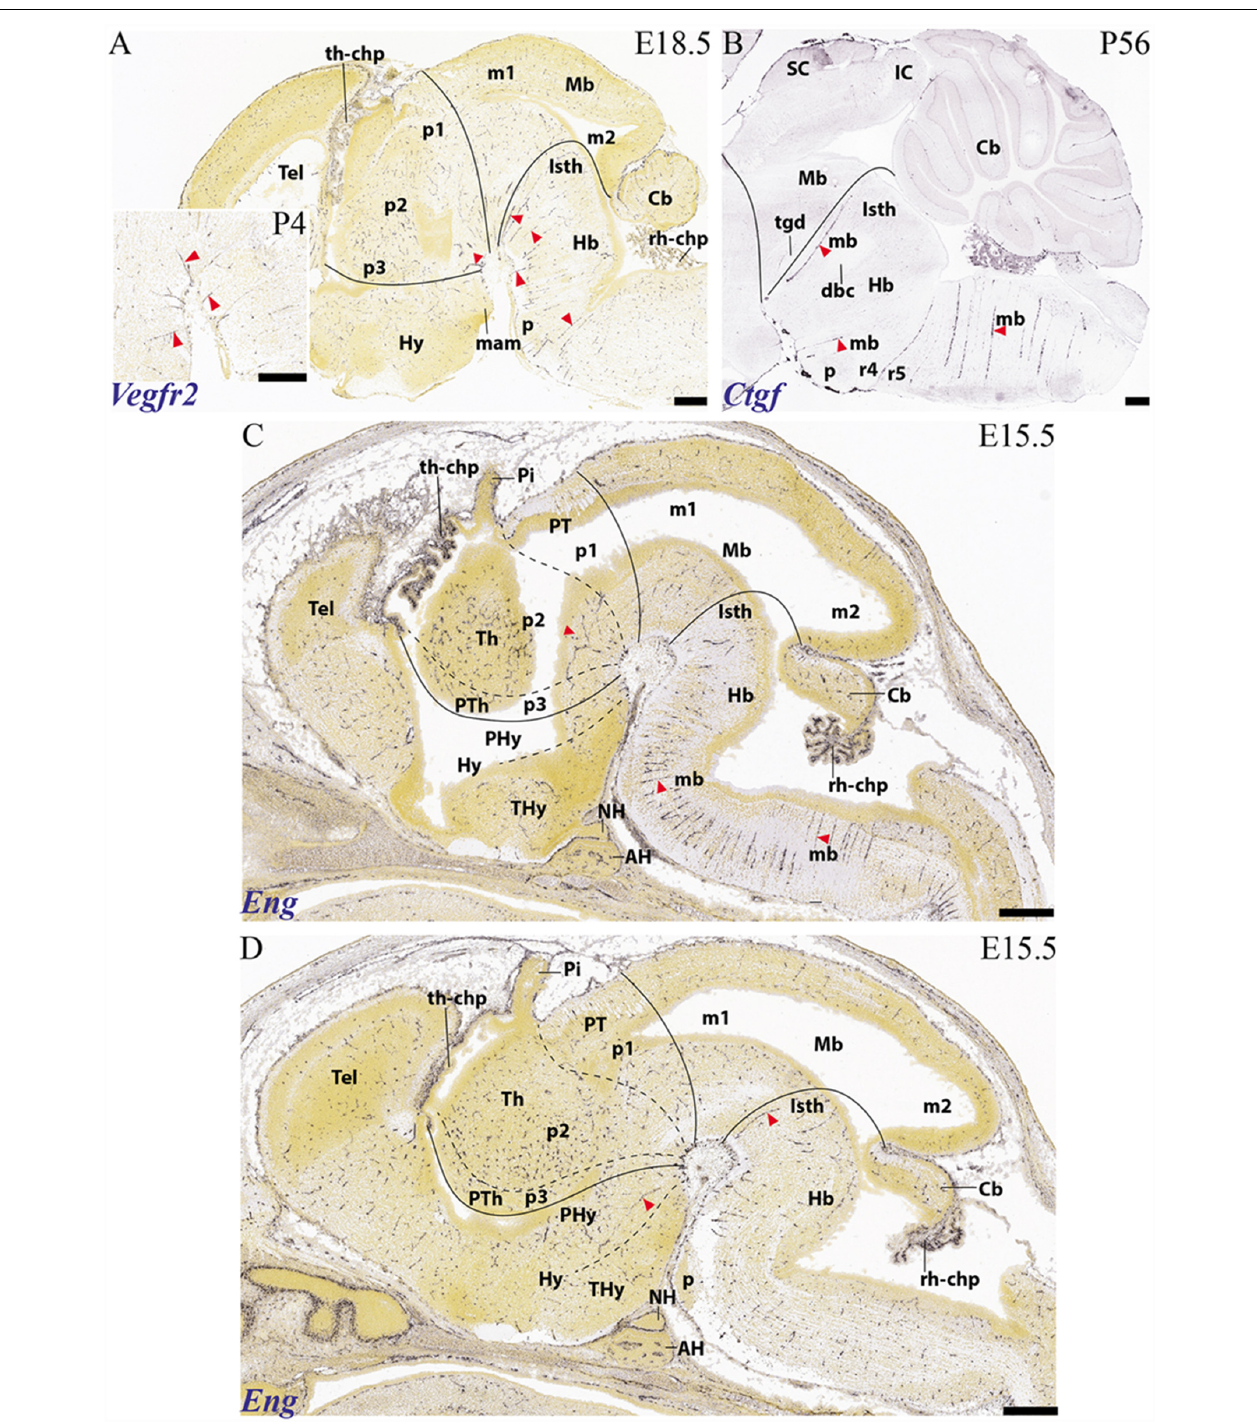
FIGURE 11 | Examples of basal arteries labeled with different gene markers in paramedian sagittal sections (material downloaded from the Allen Developing Mouse Brain Atlas). The illustrated vessels distribute along topologically transversal courses into different neuromeric units of the hindbrain and/or forebrain (major limits indicated by black lines; diencephalic and secondary prosencephalic interneuromeric limits marked by dash lines). (A) E18.5 mouse embryo, Vegfr2 labeled arteries (red arrowheads; inset shows higher magnification detail of cephalic flexure). (B) Adult mouse, Ctfg label, some radial hindbrain mediobasal arteries (red arrowheads caudal to the isthmo-mesencephalic boundary; black trace; check Mb; Isth). (C) E15.5 mouse embryo, Eng label, red arrowheads pointing out mediobasal vessels in the thalamic and hindbrain basal plate. Note also chorioidal plexi (th-chp; rh-chp). (D) E15.5 mouse embryo, Eng label, red arrowheads pointing out mediobasal vessels in the peduncular hypothalamus and the isthmic